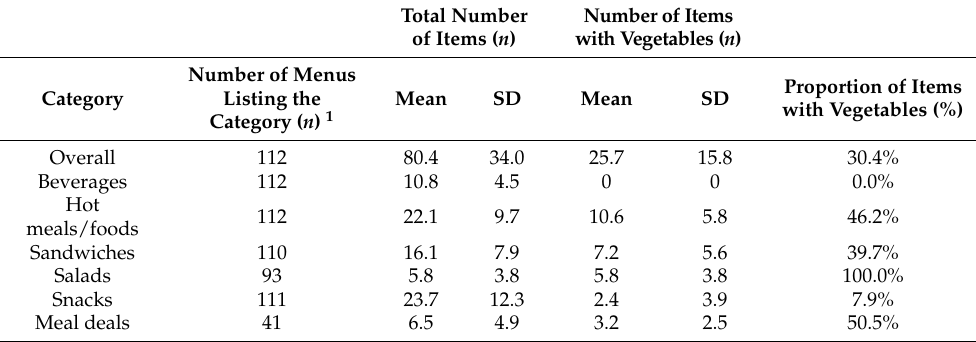
Table 1. Mean (and standard deviation, SD) of total number of menu items, number of items with vegetables and proportions of items with vegetables (%) within each menu category.